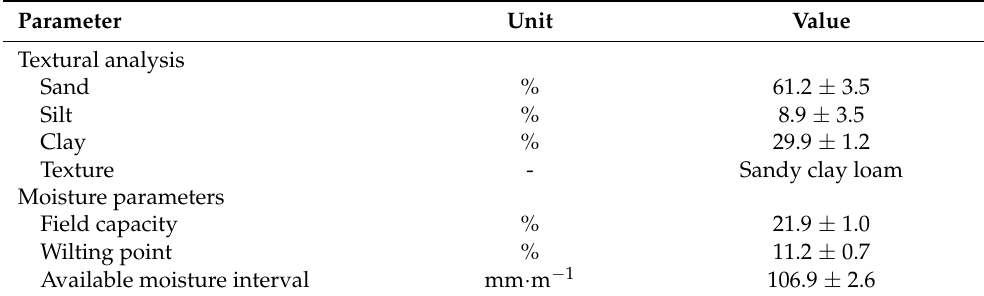
Table 1. Textural, physicochemical, and chemical properties of the soil (N = 8). EC = Electrical Conductivity; TN = Total Nitrogen; CEC = Cation Exchange Capacity.